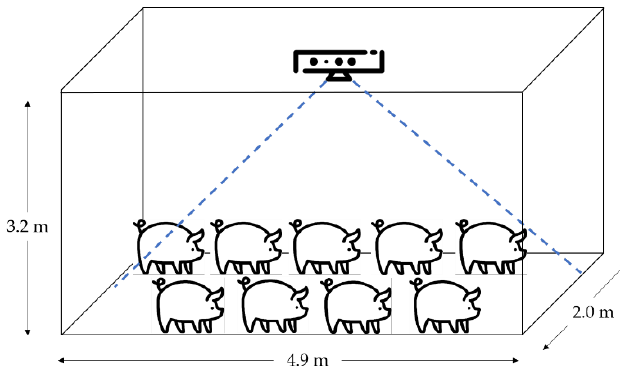
Figure 5. Experimental setup with Intel RealSense camera.